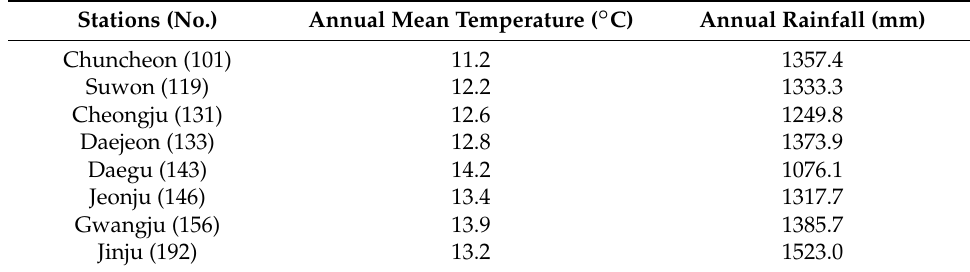
Table 2. Climatic characteristics at the eight meteorological stations.